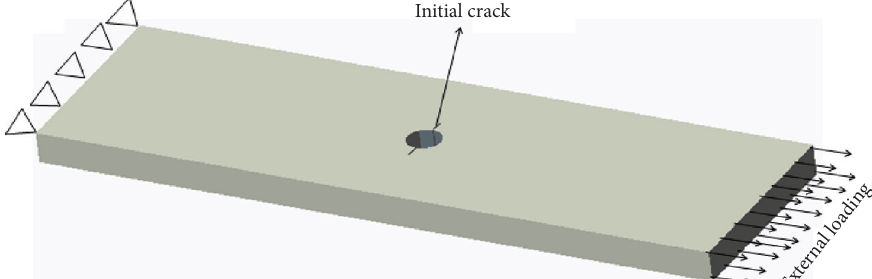
Figure 4: Plate structure with bilateral